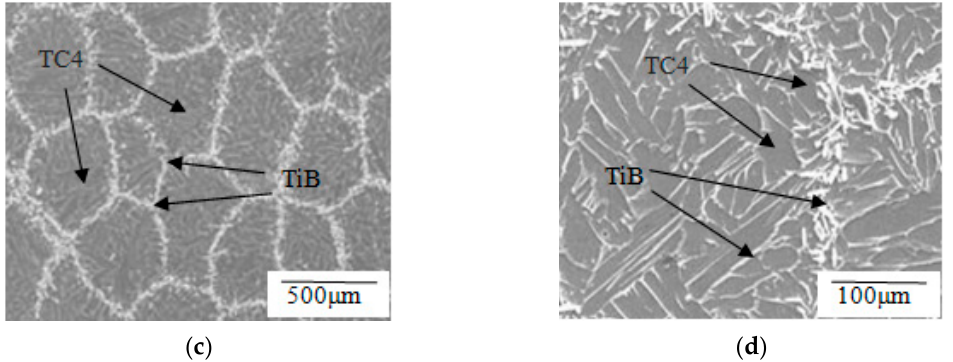
Figure 2. Composite reaction diagram and scan photos for 8.5 vol% TiBw/TC4. ( a ) Before hot pressing reaction; ( b ) After hot pressing reaction; ( c ) Low magnification scan photo; ( d ) High magnification scan photo.